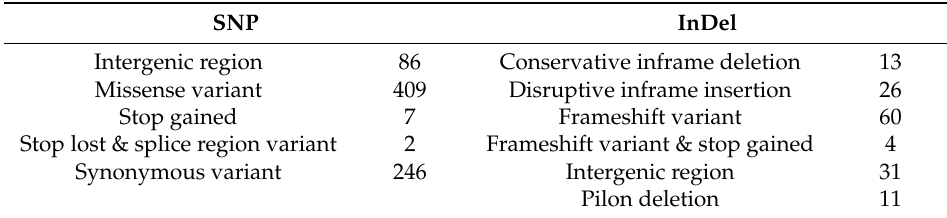
Table 1. Mutation type of single nucleotide polymorphisms (SNPs) and insertions/deletions (InDels).